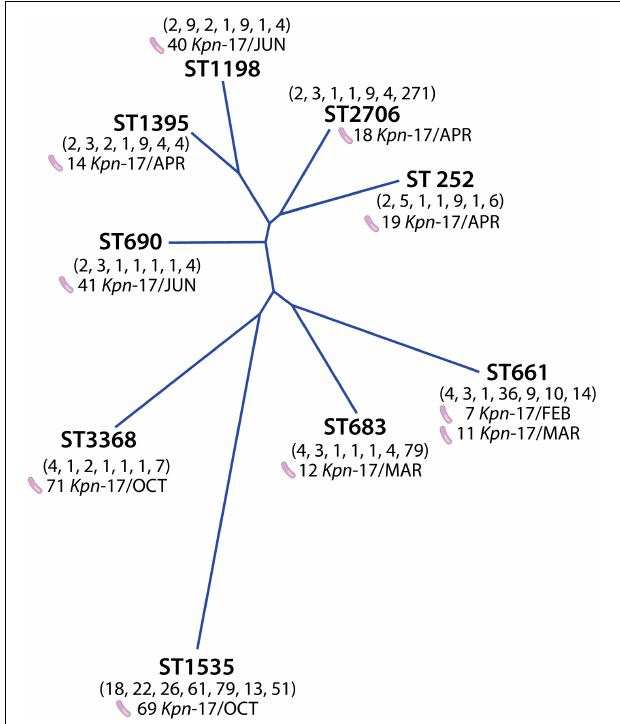
FIGURE 2 | Phylogenetic analysis of STs obtained for bla NDM − 1 -producing K. pneumoniae strains using the neighbor-joining